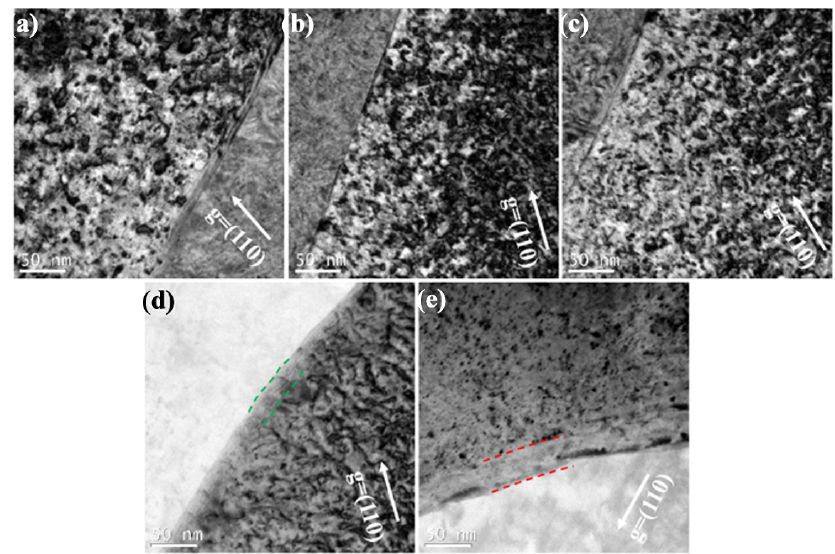
Figure 8. The dislocations distribution around the grain boundaries and precipitate interfaces within the three irradiated W ‐ based samples: ( a ) pure W, ( b ) and ( d ) sintered W ‐ 1.5ZrO 2 composites, ( c ) and ( e ) swaged W ‐ 1.5ZrO 2 composites.